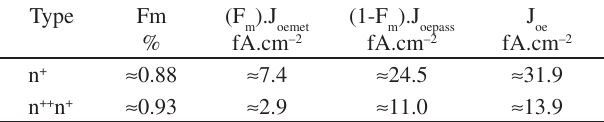
Figure 4. Passivated current density recombination, J function of surface doping concentration, N homogeneous and DD-emitters (S